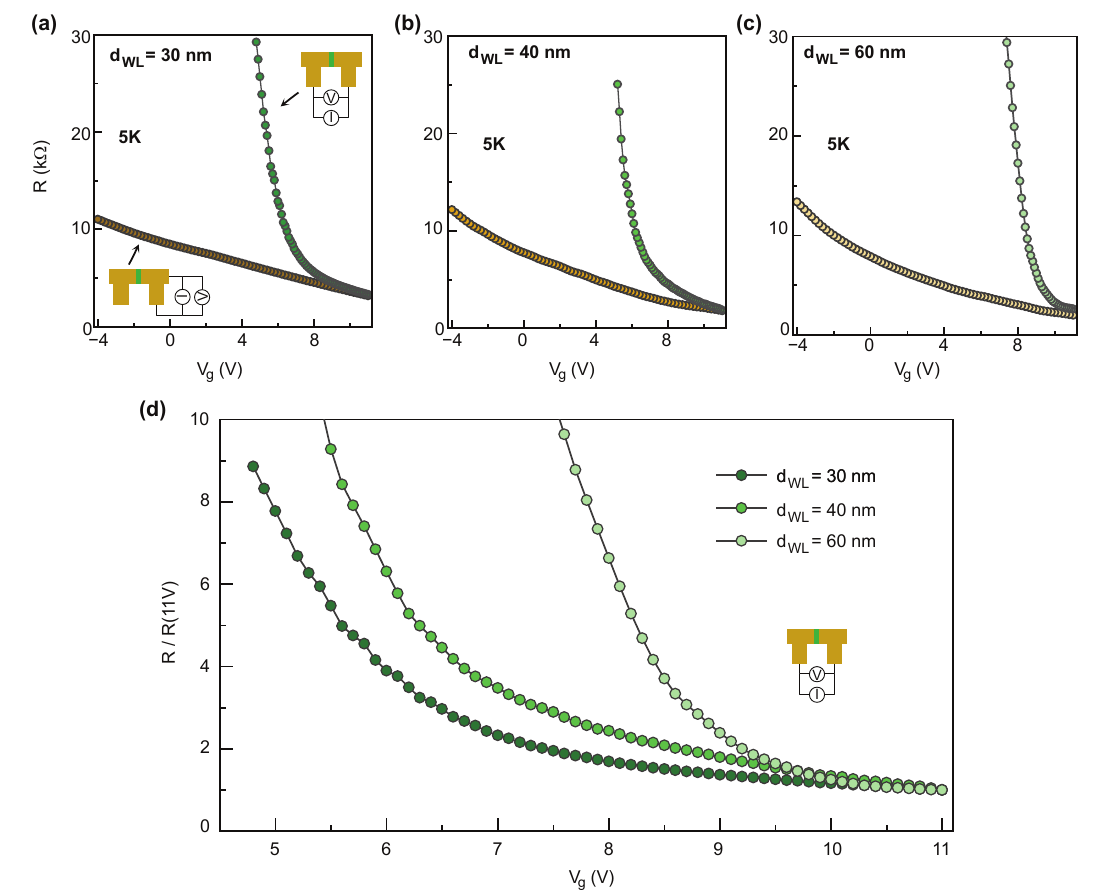
Figure 4. Normal state properties. ( a – c ) Normal resistance of three devices with barrier thickness d WL ∼ 30, 40, and 60 nm, as a function of gate voltage for weak links (green data point) and uniform channels (yellow data point) measured in two point configuration measured at T = 5 K. ( d ) Comparison of the evolution of resistance as a function of gate voltage measured across the weak link. The resistance is normalized to the values corresponding to the maximum gate voltage in all panels, R(V max